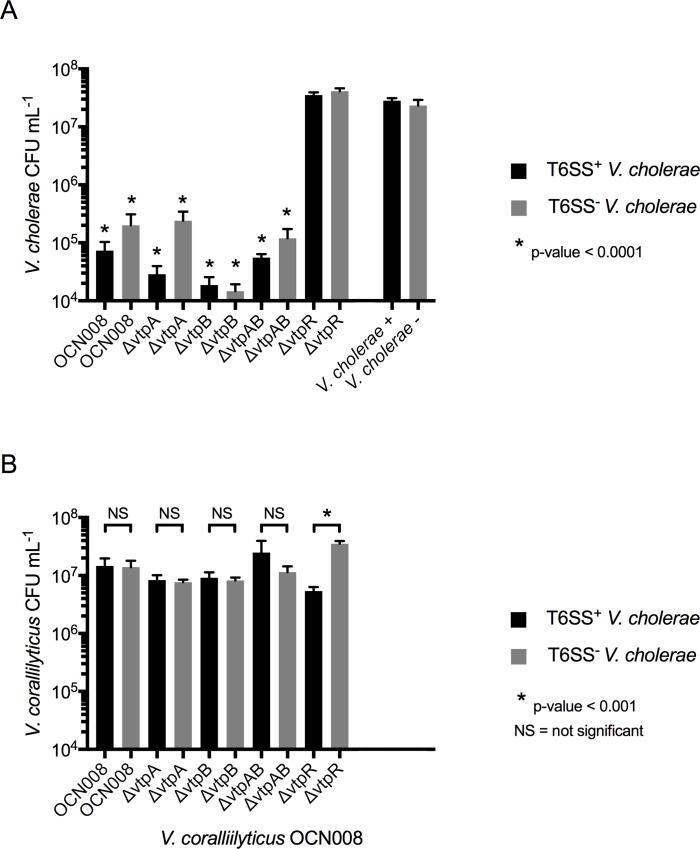
V. coralliilyticus protease-mutant challenge assays.V. coralliilyticus OCN008, protease-mutant derivatives (ΔvtpA, ΔvtpB, and ΔvtpAB), and the ΔvtpR mutant were challenged against T6SS+
V. cholerae (black bars) or T6SS-
V. cholerae (grey bars). V. cholerae strains were also grown in monoculture to serve as controls. Error bars represent the mean ±SD of three biological replicates. (A) V. cholerae CFU recovery. Asterisks denote statistically significant differences (two-tailed t-test) between the CFUs recovered for the indicated V. cholerae strain after the challenge assay in comparison to its recovery when grown in monoculture (far right of graph). (B) Brackets indicate a two-tailed t-test implemented to determine statistically significant differences between recovered CFUs mL-1 for each tested V. coralliilyticus isolate after its competition assay against either T6SS+ or T6SS-
V. cholerae.